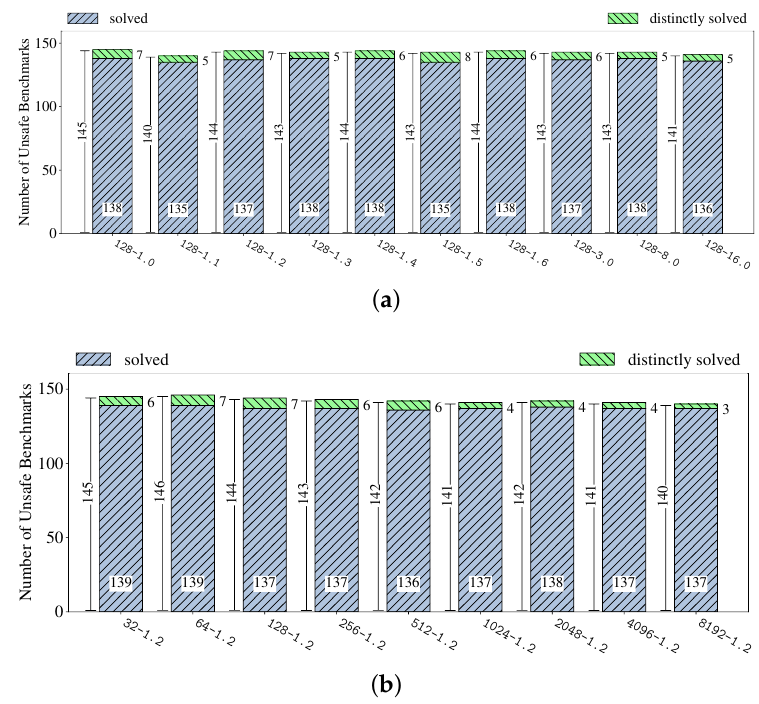
Figure 3. Number of unsafe benchmarks solved from the experiments. The category “distinctly solved” benchmarks are solved by CAR with the corresponding restart policy but not by the original CAR. The “solved” benchmarks solved by CAR with and without the restart policy. X -axis 128– 1.0 means the initial threshold = 128, gr = 1.0, and the same applies to others. ( a ) Results of the restart policy with the initial threshold = 128. ( b ) Results of the restart policy with gr =